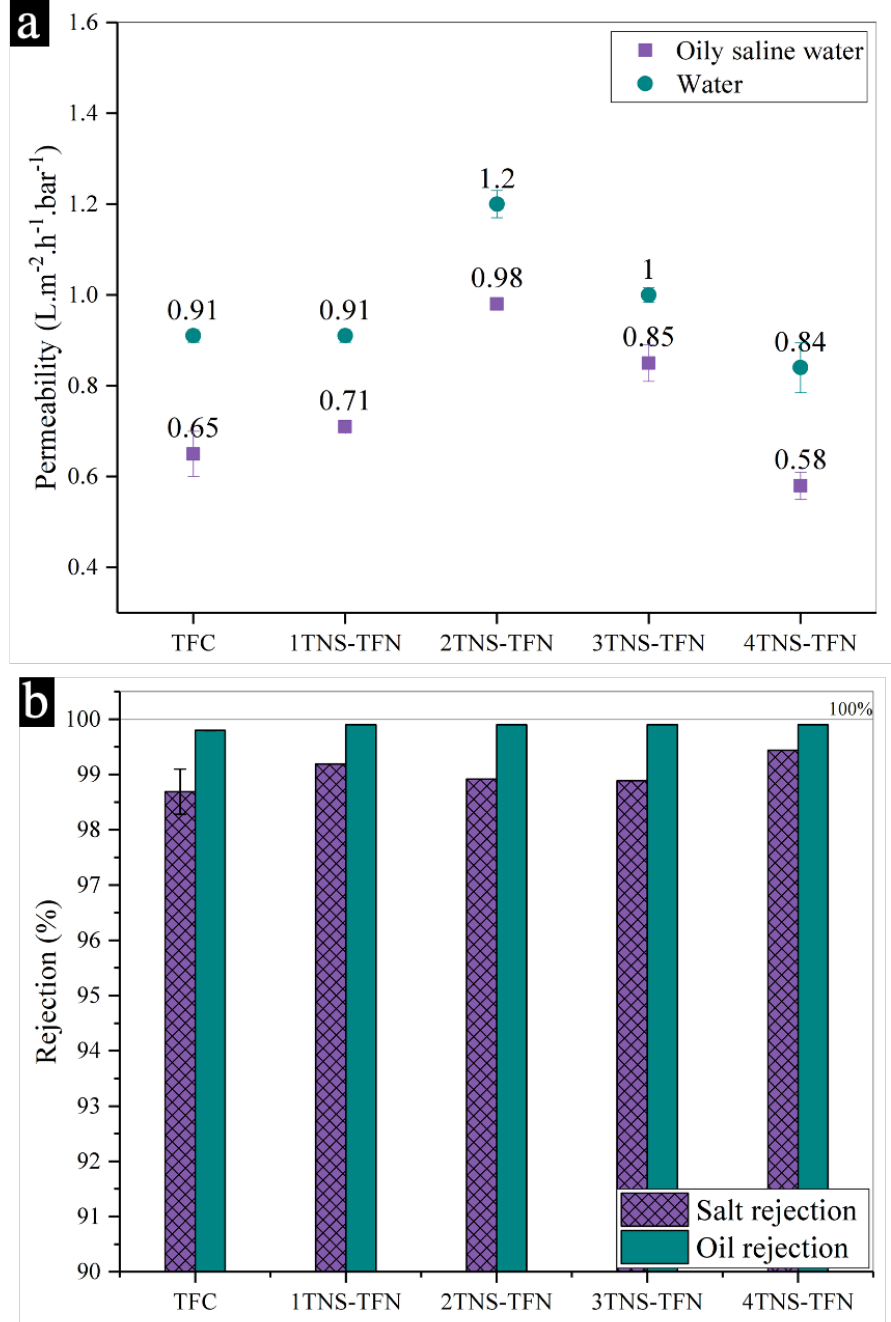
Figure 3. ( a ) Pure water and water permeabilities of membranes and ( b ) oil and salt rejections of composite membranes.